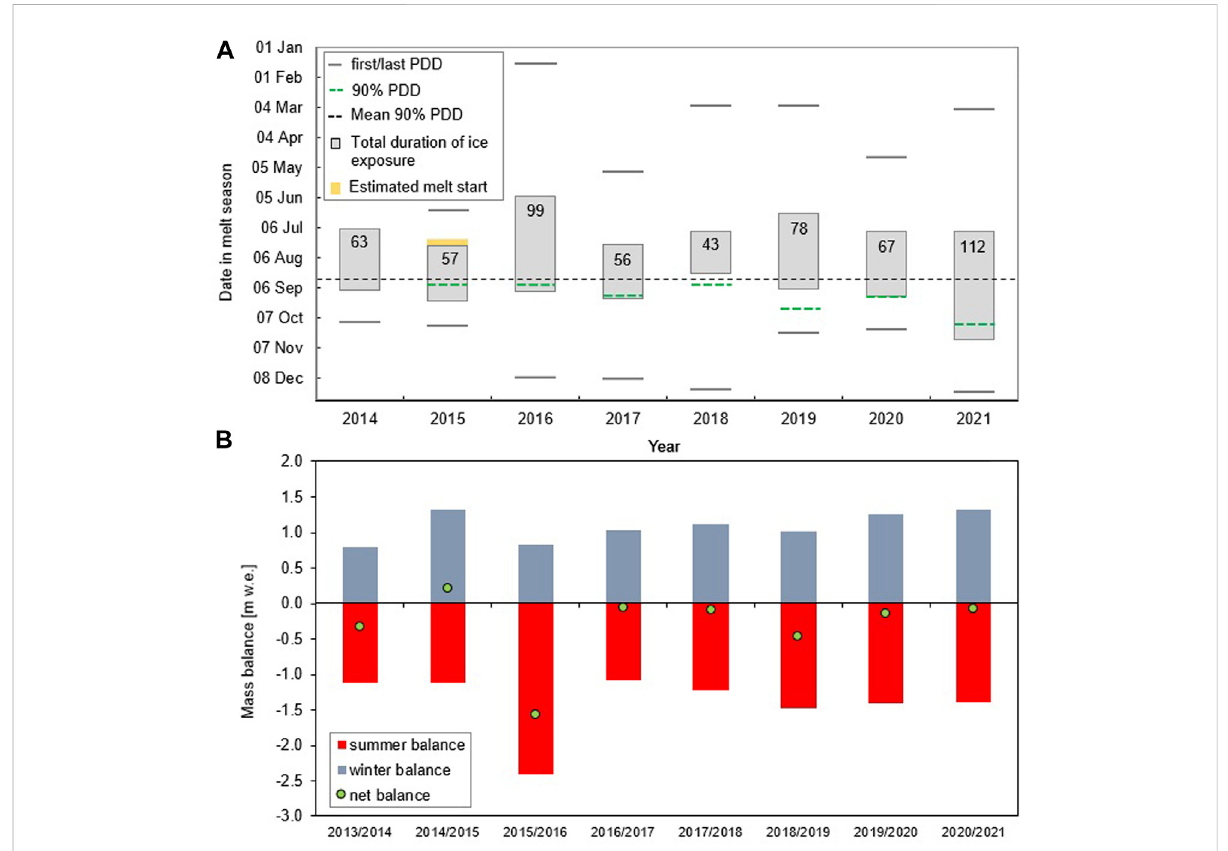
FIGURE 5 (A) Timingsofonsetofbareiceexposure(i.e.thedatethatbareiceis fi rstvisibleonQAS)andtotaliceexposureduration(i.e.thetotaldurationin days that bare ice is visible up until the fi rst day of full snowfall coverage, labelled in each bar) from time-lapse camera images taken between 2014 and 2021. The fi rst and last PDDs for each melt season are marked by horizontal black lines. The average date when 90% PDD is reached is marked as a black dashed line.In 2014, theAWS was setup after thestart of themelt season so only theend of season PDD isavailable. In 2015, thestartdateofthemeltseasonisestimatedinyellowbasedontheaveragestartdatefromcameraimagesinothermeltseasons. (B) Winterbalance, summer balance and net balance from mass balance stakes on QAS. Stake locations are shown in Figure